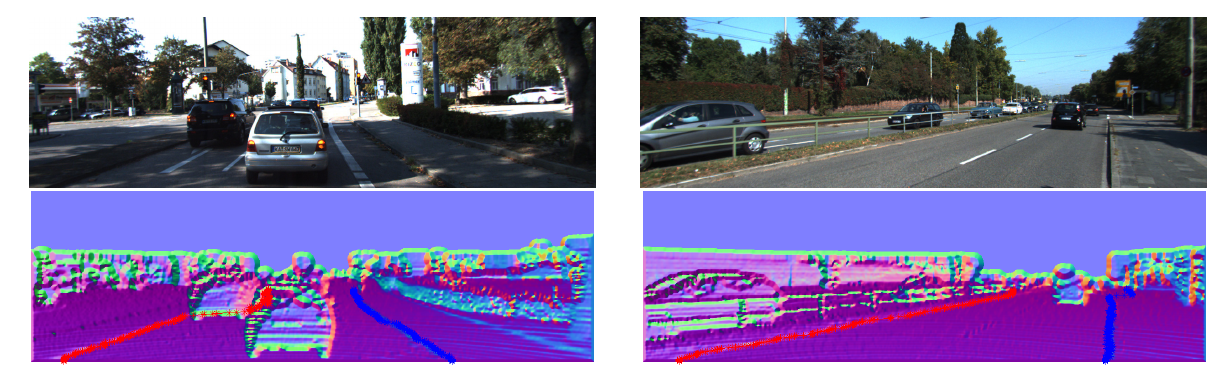
Figure 19. ( a ) Curbs with obstacle occlusion; ( b ) Vehicle direction change